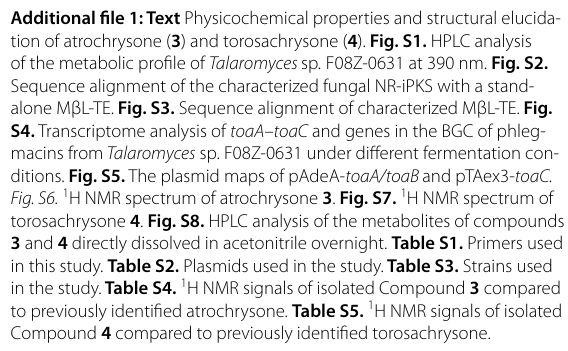
Fig. S6. 1 H NMR spectrum of atrochrysone 3 . Fig. S7. 1 H NMR spectrum of torosachrysone 4 . Fig. S8. HPLC analysis of the metabolites of